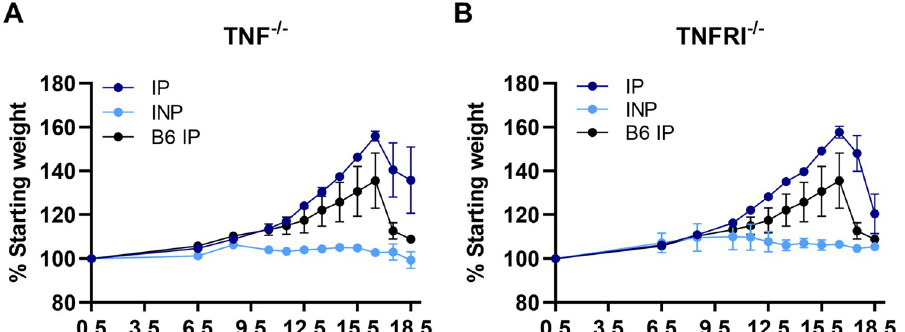
Fig 7. Tumor necrosis factor (TNF -/- ) and tumor necrosis factor receptor 1 (TNFRI -/- ) deficient mice experience preterm delivery following P . chabaudi infection on E8.5. (A) Percent starting weight for TNF -/- and (B) TNFRI -/- mice are depicted for infected pregnant (IP) and infected non-pregnant (INP) groups. TNF -/- IP: n = 3, INP n = 3; TNFRI -/- IP: n = 7, INP n = 3; B6 IP: n = 5. All IP mice experience precipitous weight loss, indicating preterm pregnancy